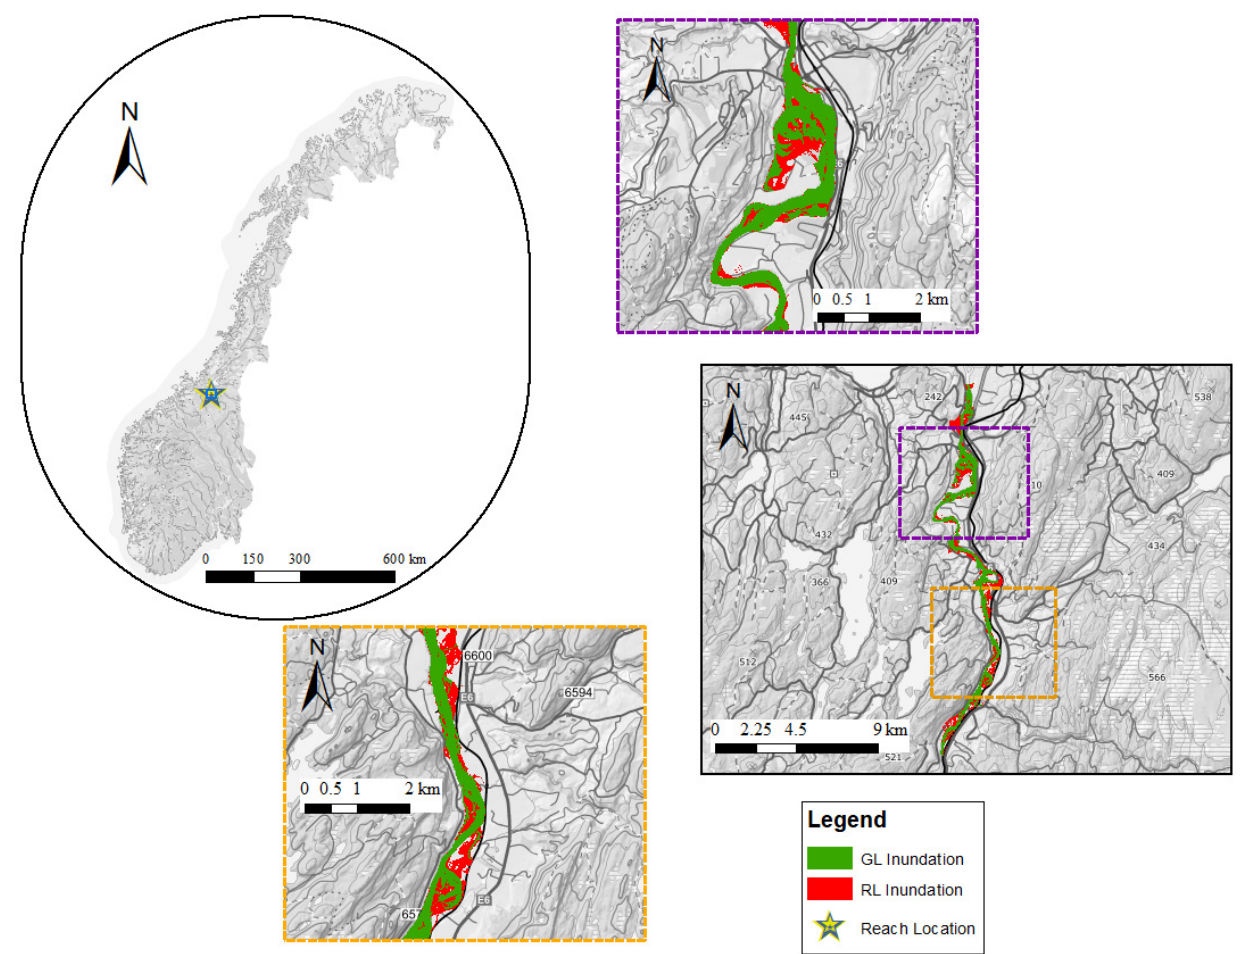
Figure 4. Flood extent for the 50-year return period scenario for the Gaula site using different LiDAR DEMs. GL and RL denote Green LiDAR and Red LiDAR, respectively.